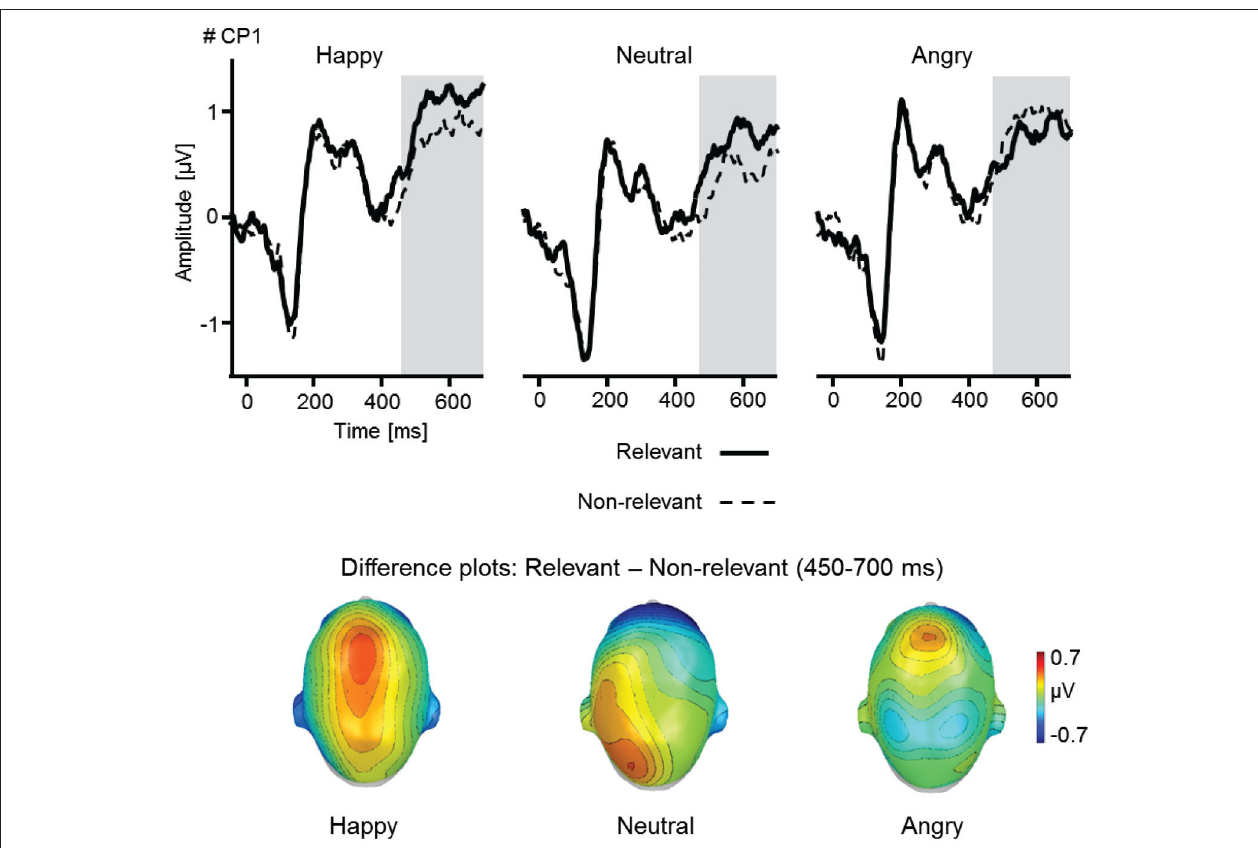
or non-relevant. Topographical difference maps (relevant–non-relevant) display the averaged time interval (450–700 ms) plotted on a top view of a model head. Analyzed time window for the LPP are highlighted in